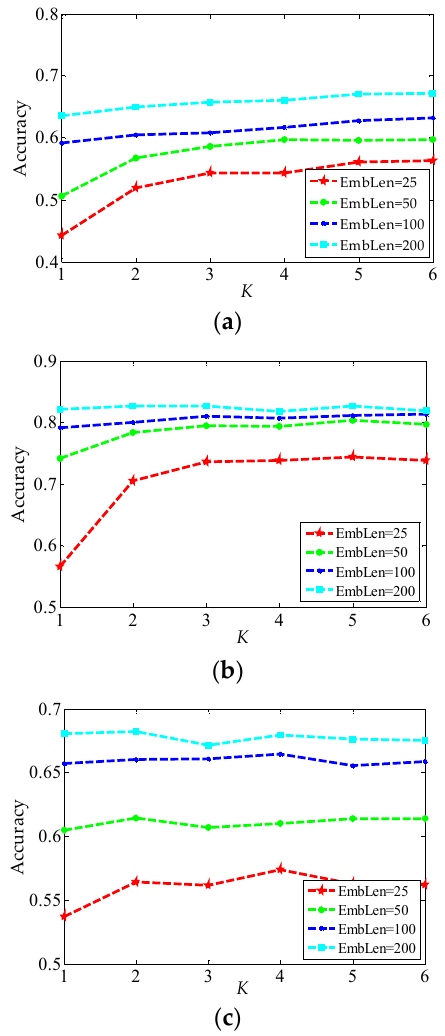
Figure 2. Parameter sensitivity analysis, here, we mainly research the influence of representation vector size and K value to network classification task. ( a ) parameter sensitivity analysis on Citeseer dataset; ( b ) parameter sensitivity analysis on Cora dataset; ( c ) parameter sensitivity analysis on Wiki dataset.